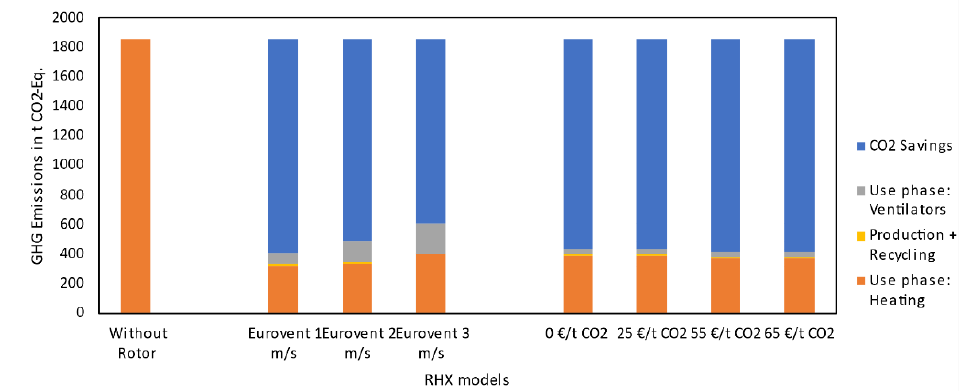
Figure 6. Total life cycle GHG emissions in CO 2 Eq. for different optimized RHXs and the Eurovent model at an FU of 100,000 m 3 /h.